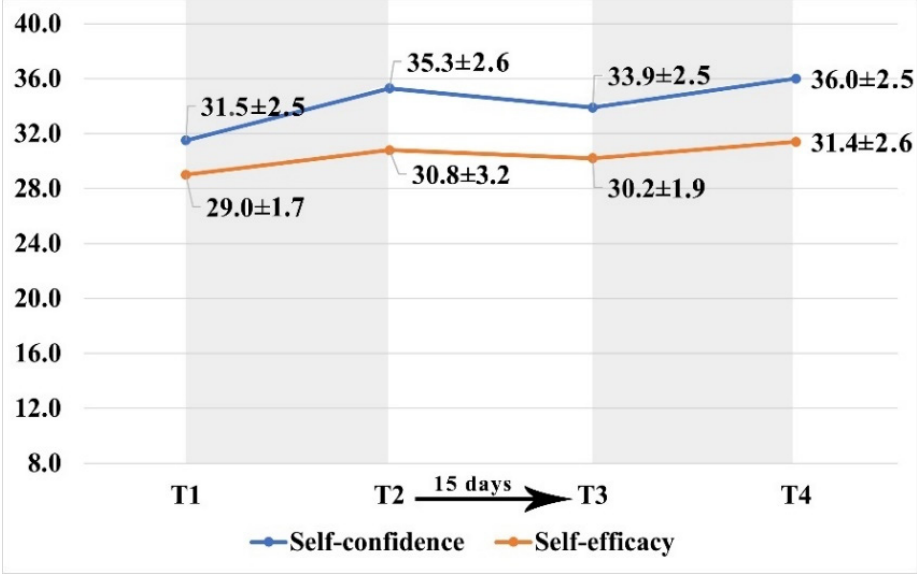
Figure 3. Self-confidence and self-efficacy over time.